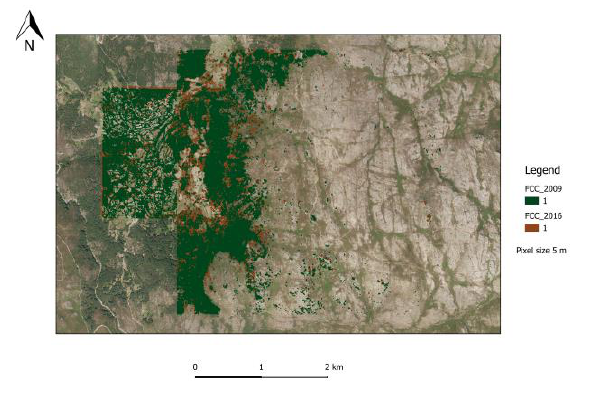
Figure 5. FCC calculated for high vegetation